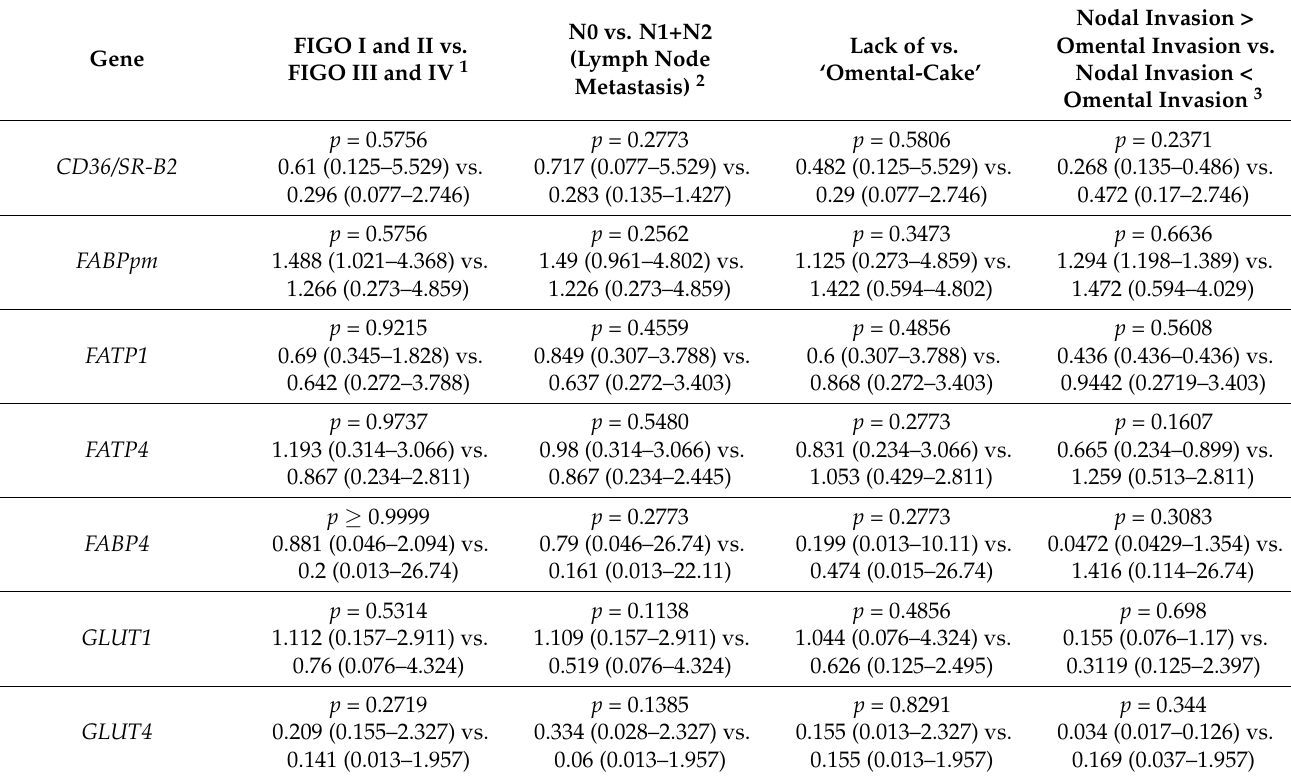
Table A1. Relative gene expression in relation to clinical–pathological parameters. The values are presented as median